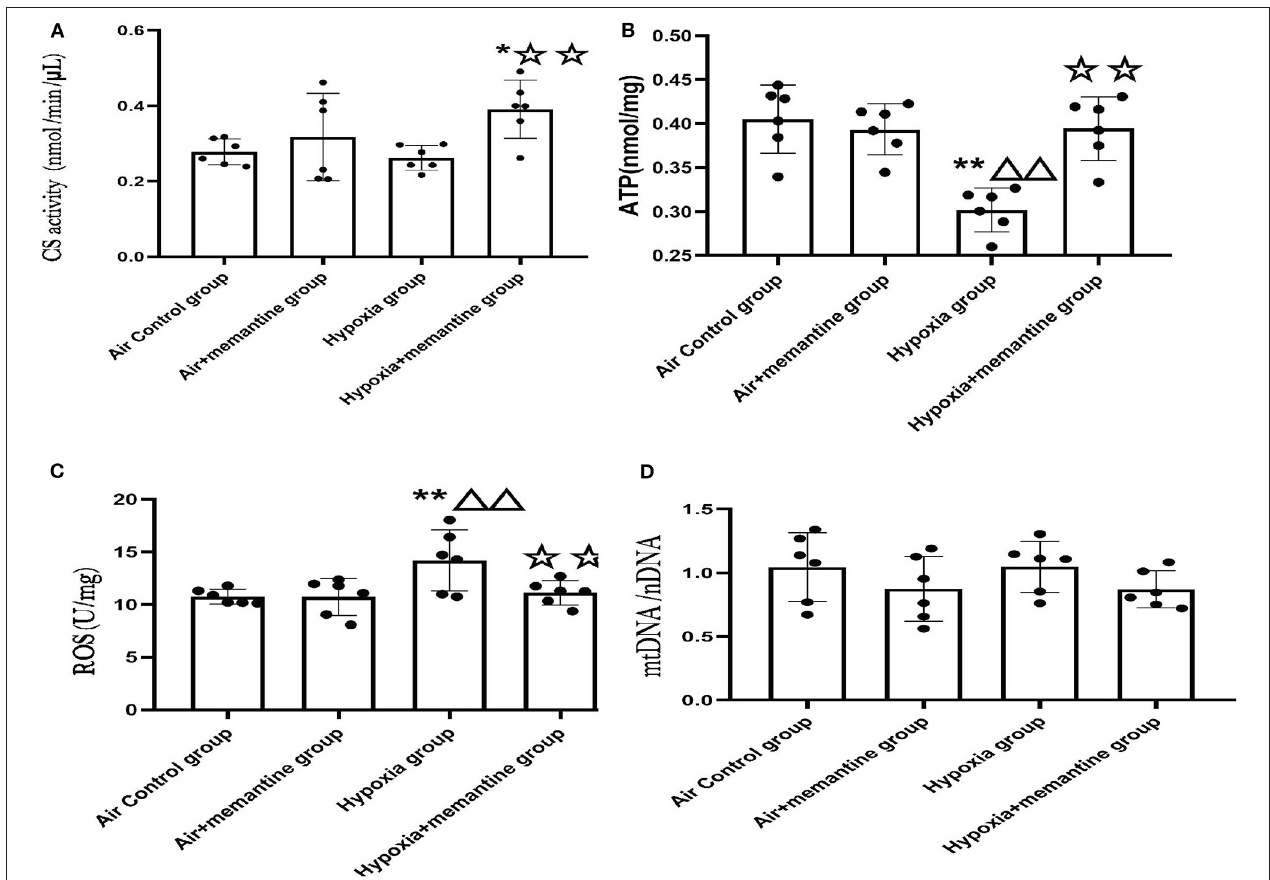
FIGURE 5 | Antenatal memantine treatment attenuated the mitochondrial dysfunction in neonatal rat heart induced by intrauterine hypoxia. (A) CS activity in different groups (nmol / min /µ L); (B) ATP concentration in different groups (nmol/mg); (C) ROS levels in different groups (U/mg); (D) mtDNA copy number (mtDNA/nDNA) in different groups. Compared with the air control group: * P < 0.0 ; ** P < 0.01; △ P < 0.05, △△ P < 0.01; compared with the air+memantine group: △ P < 0.05, △△ P < 0.01; compared with the hypoxia group: P P < 0.05, PP P < 0.01. All data are presented as mean ± S.E.M. N =